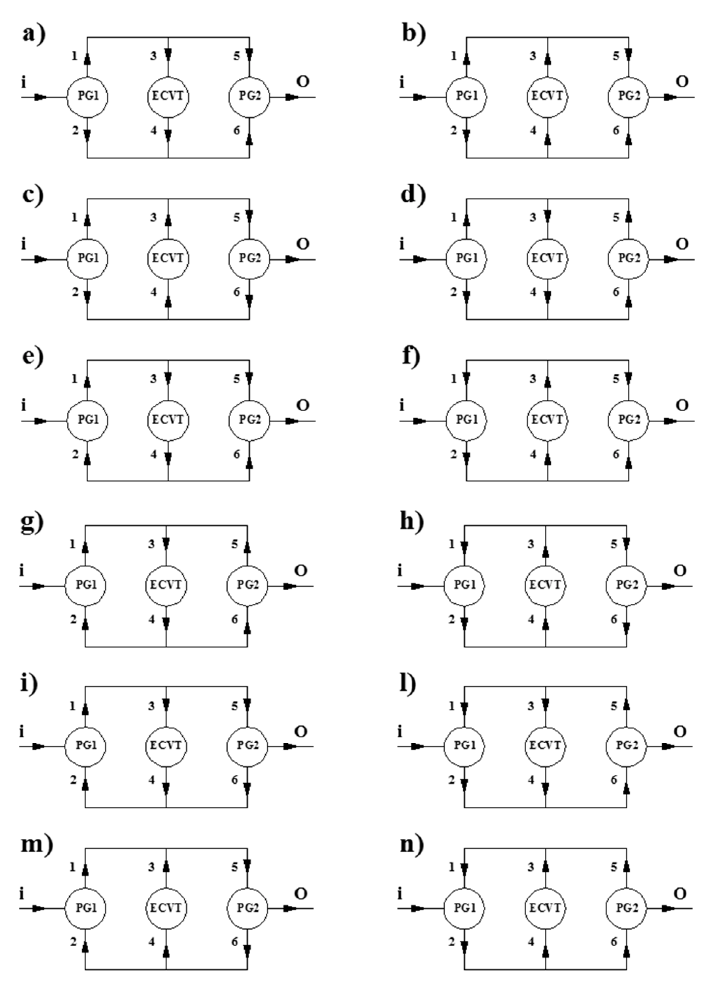
Figure 2. Power flows types.